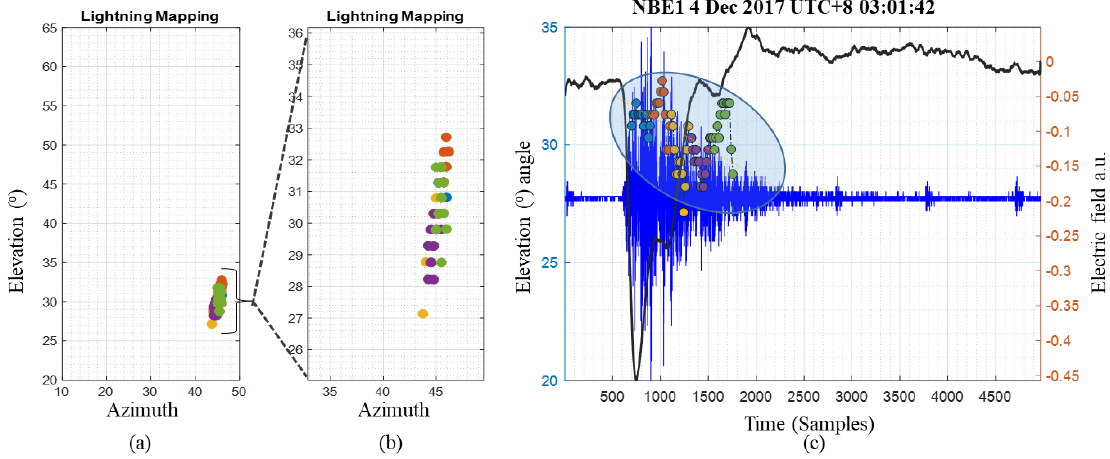
Figure 10. Interferometer data for NBE1: ( a ) lightning map plotted in elevation vs. azimuth; ( b ) expanded view of lightning map of ( a ); ( c ) the breakdown of each colored circle-marker denotes the elevation angles (altitude) vs. time.